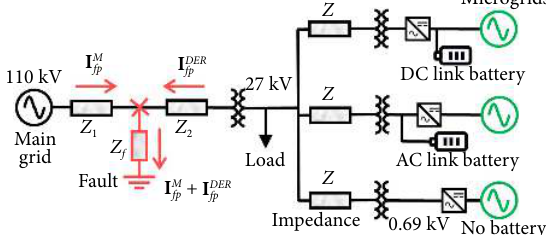
Fig. 2 Diagram of studied